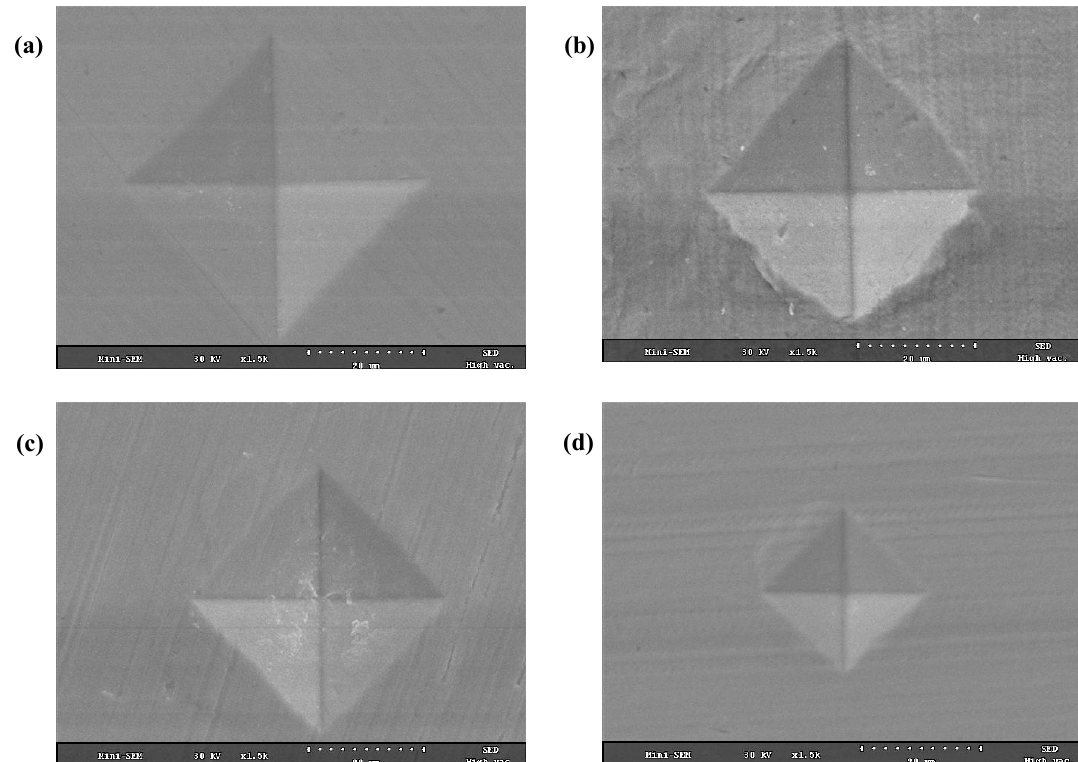
Figure 7. SEM images of an indent on the bulk ( a , b ) and 3D-printed ( c , d ) AISI H13 tool steel specimens before and after UNSM treatment.